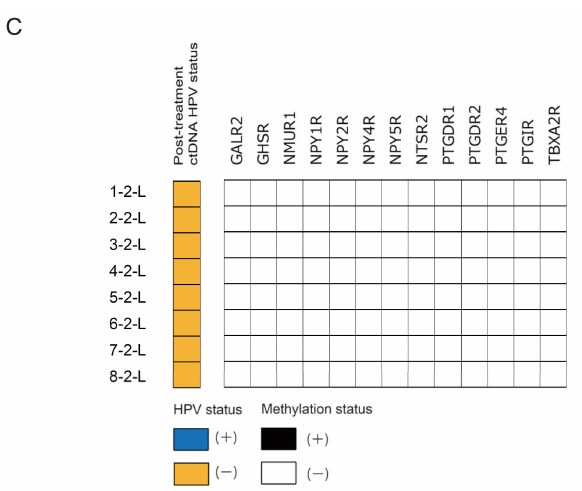
Figure 6. Validation analysis of methylation status in clinical primary samples and paired ctDNA samples. Comparison of methylation statuses represents the methylation status of these 13 markers in ( A ) 8 primary samples, ( B ) ctDNA isolated from the same patients before treatment as above, and ( C )